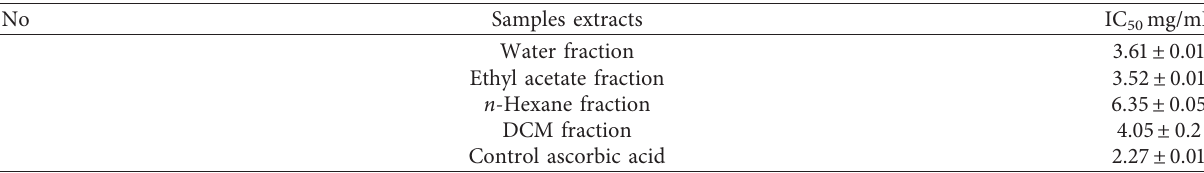
Table 3: DPPH activity results of different fractions of S. triqueter plant.